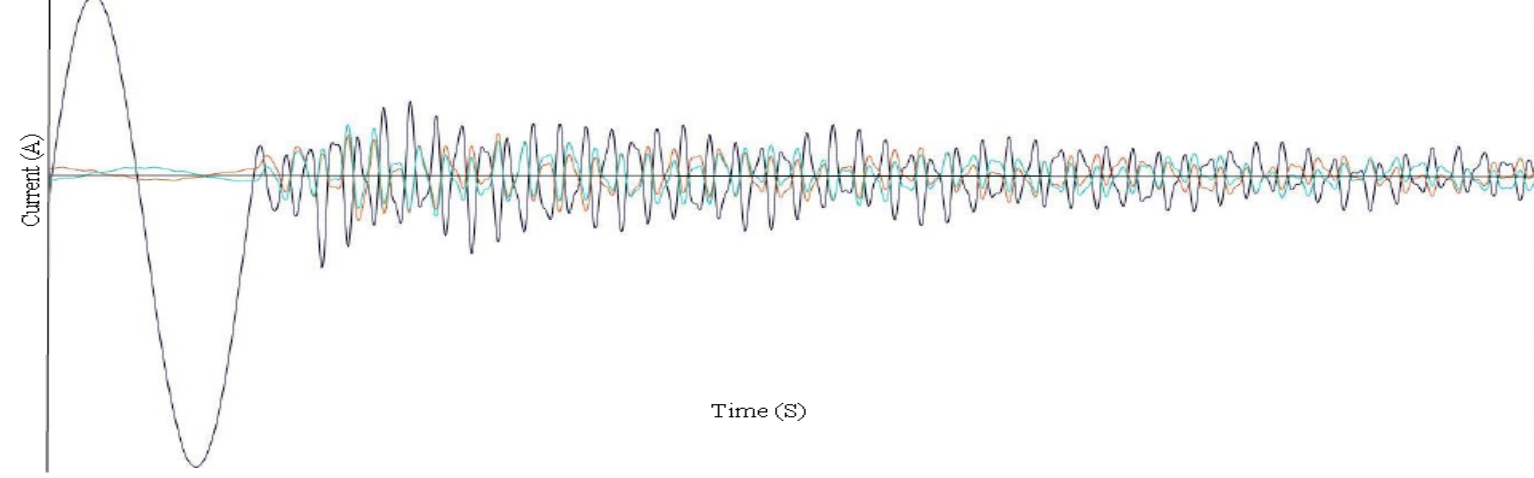
Figure 11. Single-phase-to-ground signal.